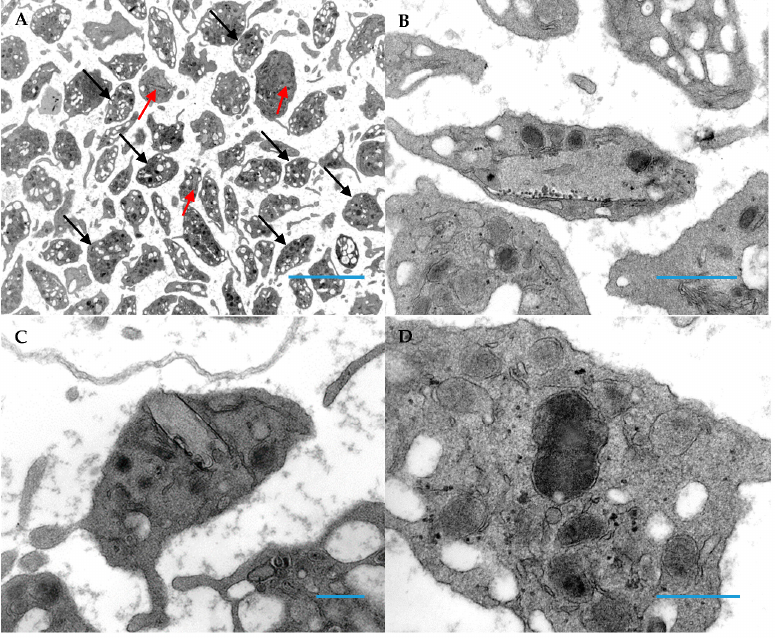
Figure 2. Platelets sectioned from epoxy embedded buffy coat of patient 1. ( A ) Unusual inclusions (red arrows) are almost impossible to visualize at low magnifications; black arrows indicate normal platelets (Original magnification 3000×; Blue Bar = 10 microns). ( B ) An inclusion occupies most of the platelet cytoplasm (Original magnification 13,000×; Blue Bar = 1 micron). ( C ) An inclusion appears to merge with the cell membrane; this represents an inclusion that deforms the platelet’s shape and “sticks-out” from the cell (this section is just above/below of the protrusion “out” of the platelet (Original magnification 13,000×; Blue Bar = 1 micron). This type of inclusion is easily identified in platelet whole mounts. ( D ) This image demonstrates a giant alpha granule created by fusion of 2 or more alpha granules and is characteristic of Medich syndrome (Original magnification 30,000×; Blue Bar = 1 micron); these giant alpha granules are similar to those seen in chromosome 11q deletion syndrome (Jacobsen/Paris-Trousseau syndromes).